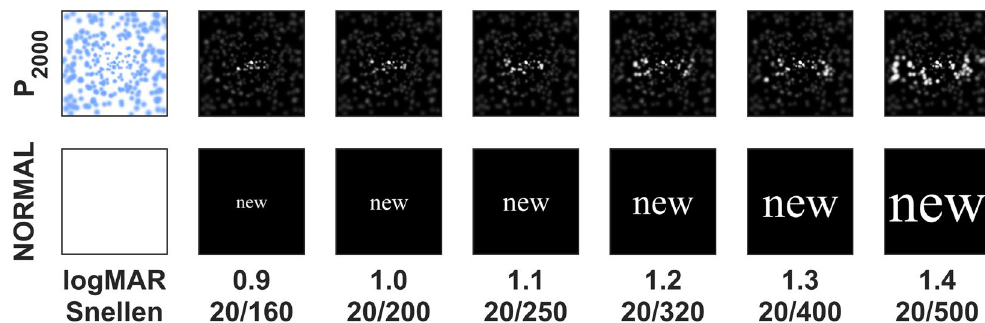
Figure 7. Stimulus conditions and font sizes. Example renderings of text used during the simulations is shown for the Normal condition (bottom row) where text is rendered at the native resolution of the screen, and the phosphene view conditions (top row) where text is shown as seen through a collection of 2000 phosphenes. The central part of the screen, approximately 10 degrees of visual angle across, is depicted for the six different font sizes used. Font sizes were calibrated to correspond to 0.9 logMAR (smallest) through 1.4 logMAR (largest). The central part of the phosphene pattern corresponding to the screen areas rendered here is shown in the upper left square, with each phosphene appearing as a light blue Gaussian on a white background. When this pattern is used as a filter on the white text/black background, it results in the images in the top row, for gaze and camera positions both at the center of the screen. As the gaze location moves around in either of the phosphene view conditions, the phosphene pattern is stabilized on the retina, but the scene camera is steered according to the testing condition of the mini-block (Full Gaze or Head Only).